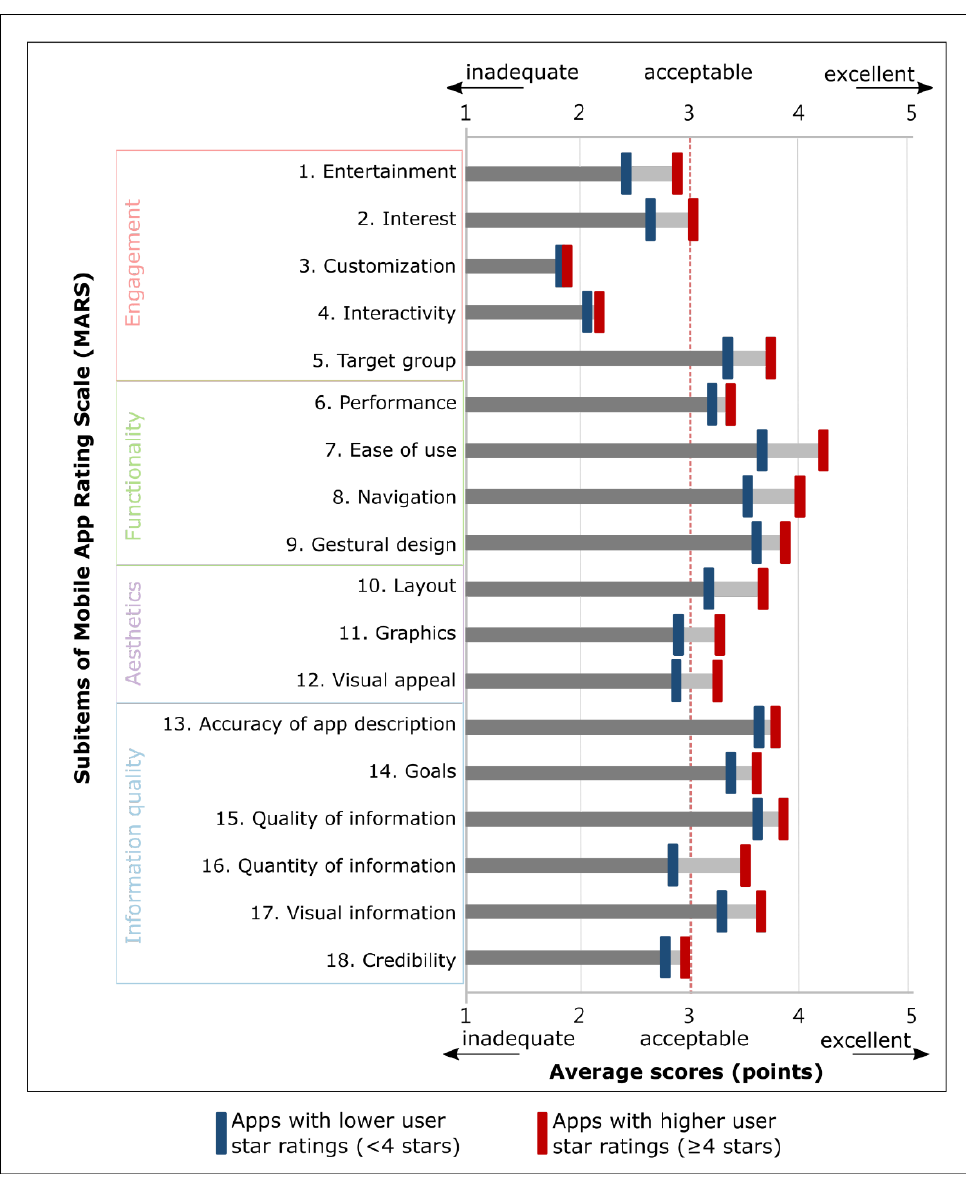
Figure 2. Average scores of items in Mobile App Rating Scale (MARS) of drug reference apps ( n = 23. Taiwan, 2021). Each horizontal bar denotes an item of MARS. The blue vertical point represents each item’s average score of drug reference apps with lower user star ratings (user ratings < 4 stars), whereas the red vertical point represents the average score of apps with higher user star ratings (user ratings ≥ 4 stars). The light gray bar between two vertical points represents the difference of average score between apps with higher user ratings and those with lower user ratings.